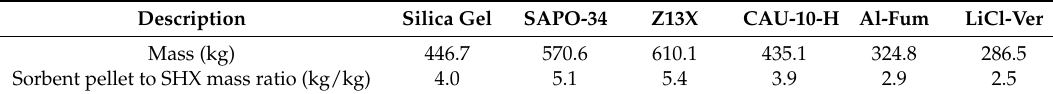
Table 5. Main characteristics of sorption storage with considered materials.